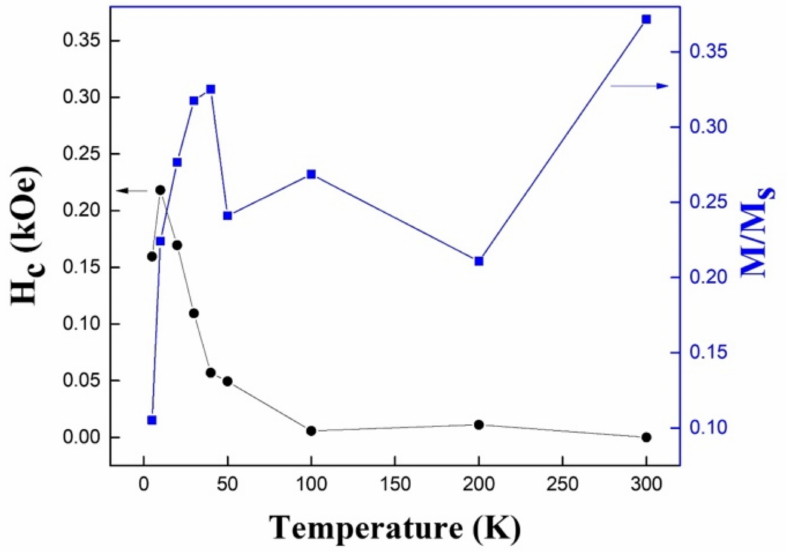
Figure 8. Coercivity (black circles) and reduced remanence (blue squares) for hollow Fe 3 O 4 nanospheres as a function of